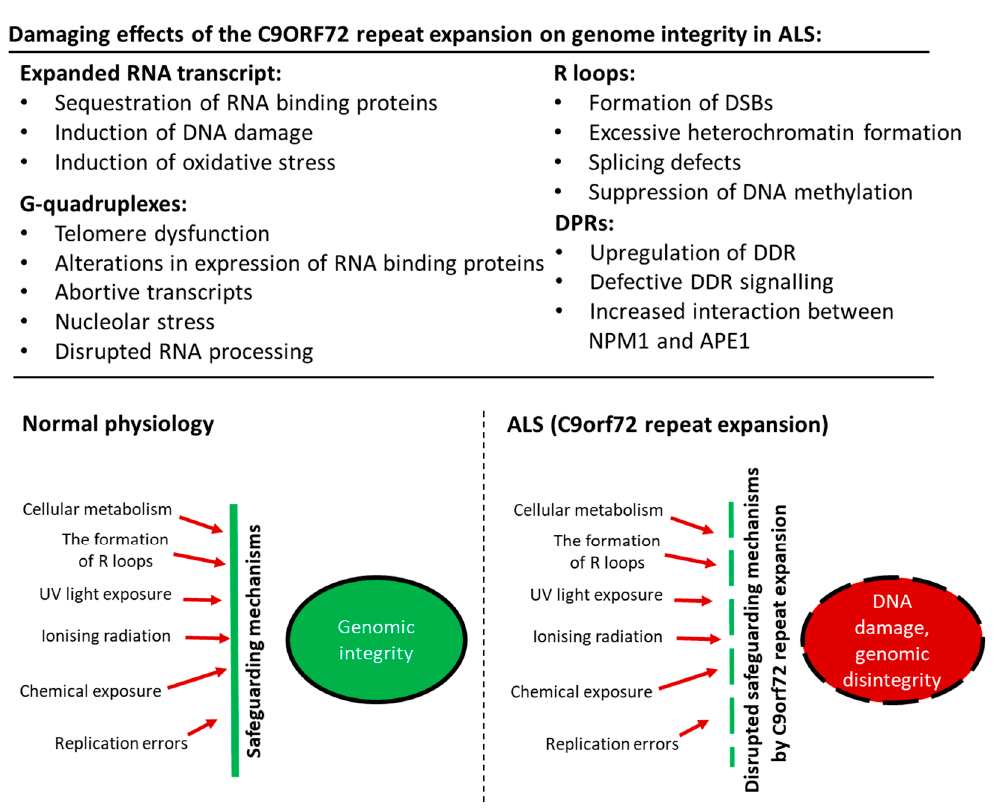
Figure 1. Scheme illustrating mechanisms by which genomic integrity is disrupted by the C9orf72 repeat expansion in ALS. Cells are exposed to exogenous and endogenous sources of DNA damage, such as normal cellular metabolism, the formation of R-loops, UV light exposure, ionising radiation, chemical exposure, and replication errors. In normal physiological conditions, the integrity of the genome is preserved by safeguarding mechanisms: the DDR and the nucleolus. However, in ALS, transcription of the C9orf72 repeat expansion leads to the production of expanded RNA transcripts. Furthermore, DPRs and abnormal DNA structures, such as R-loops, hairpins, and G-quadruplexes, are formed. These conformations compromise the normal cellular protective mechanisms, leading to persistent DNA damage and loss of genomic integrity.